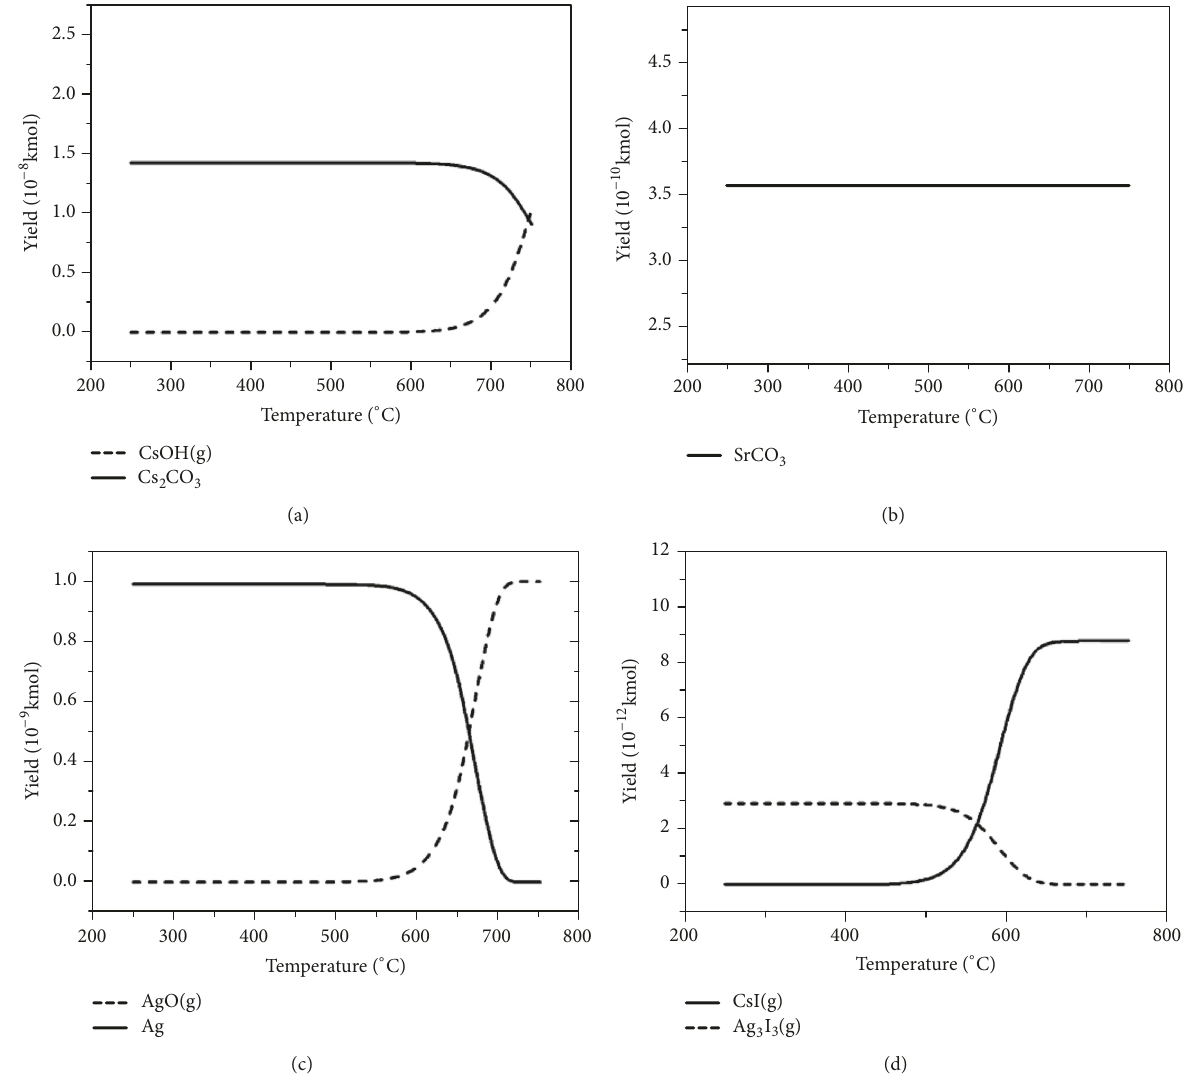
Figure 4: Variations in the chemical forms: (a) Cs, (b) Sr, (c) Ag, and (d) I.